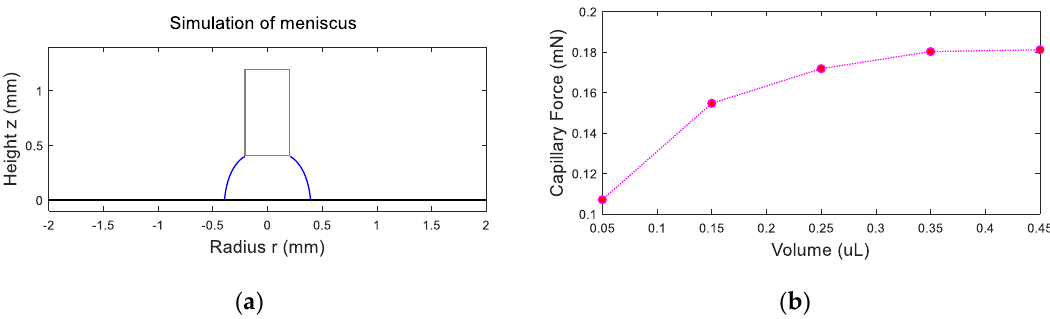
Figure 3. Simulation of meniscus and capillary lifting force analysis: ( a ) simulation of water meniscus of 0.15 μL with double iteration method; ( b ) capillary lifting force as the function of volume of the meniscus.